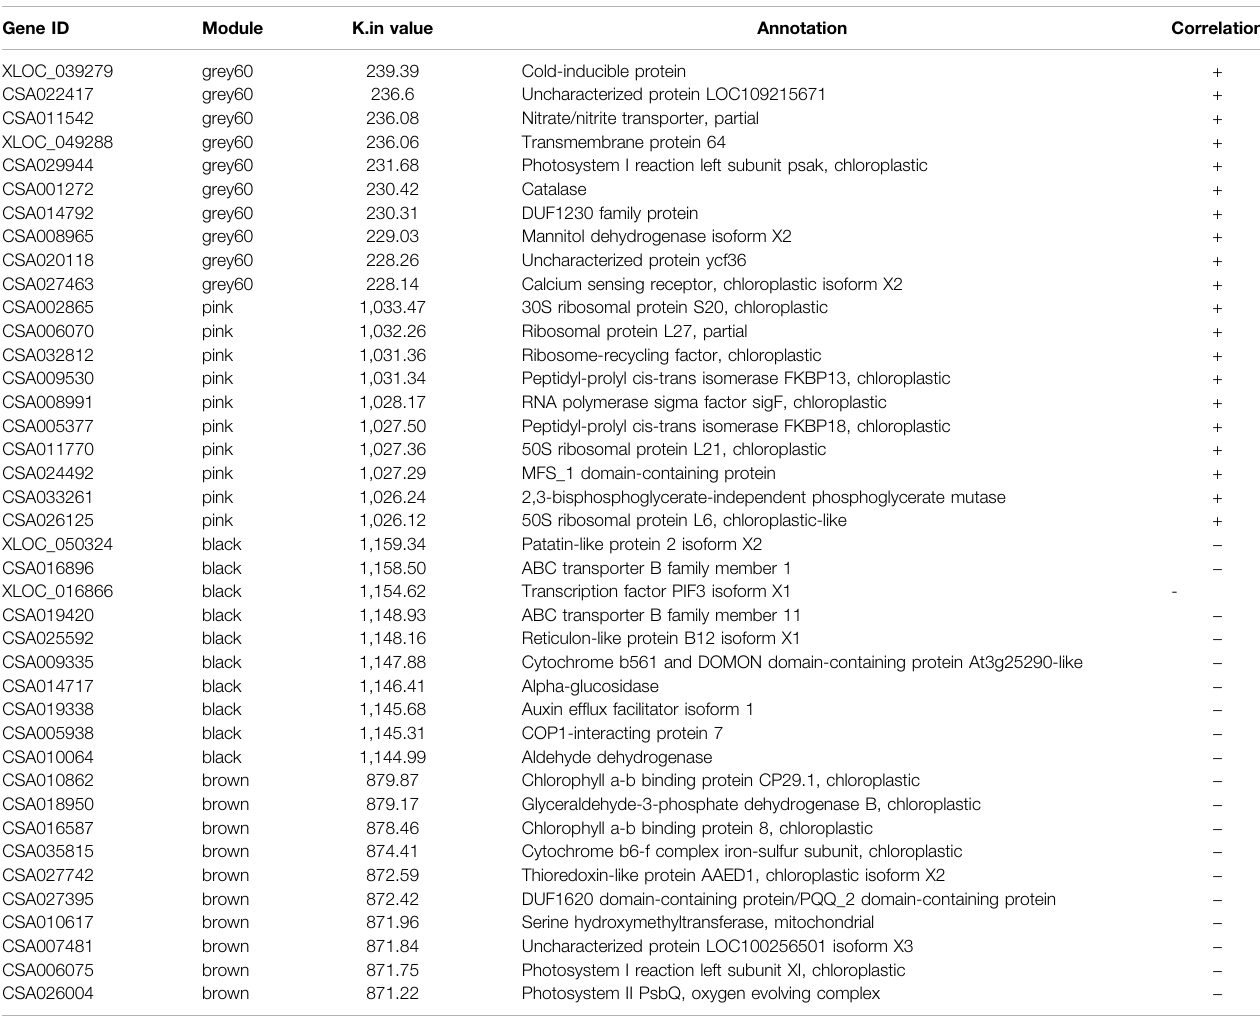
TABLE 1 | List of top ten genes in each module with the K.in